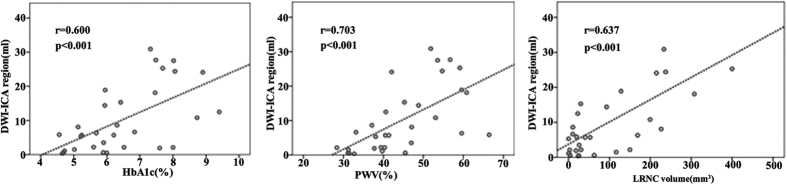
Scatterplots depicting the relationship of the significant predictors with the cerebral infarction severity.